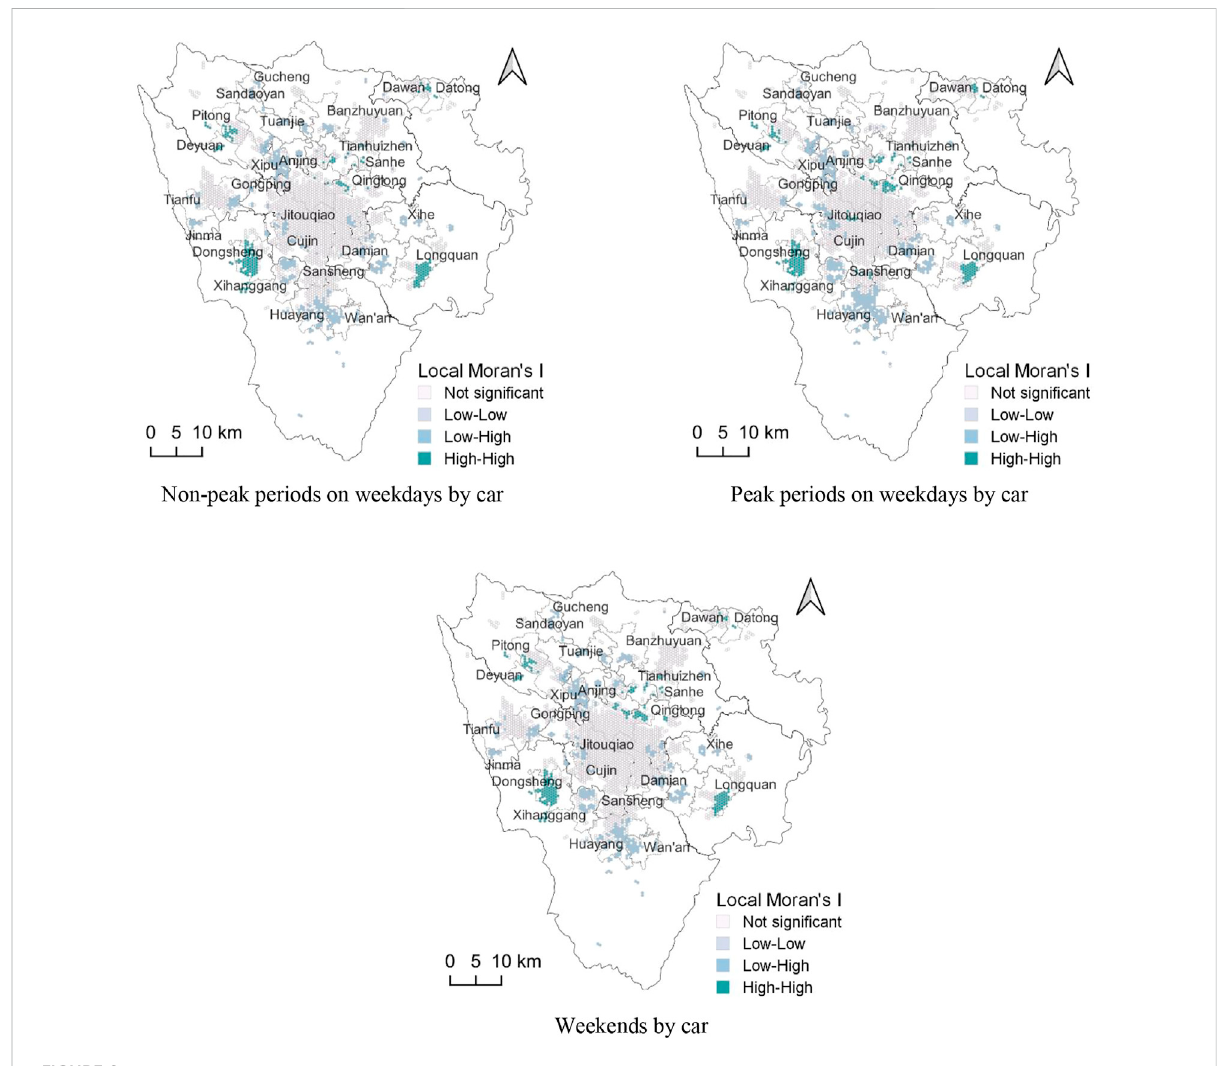
FIGURE 9 Partial clustering of park accessibility by driving in three